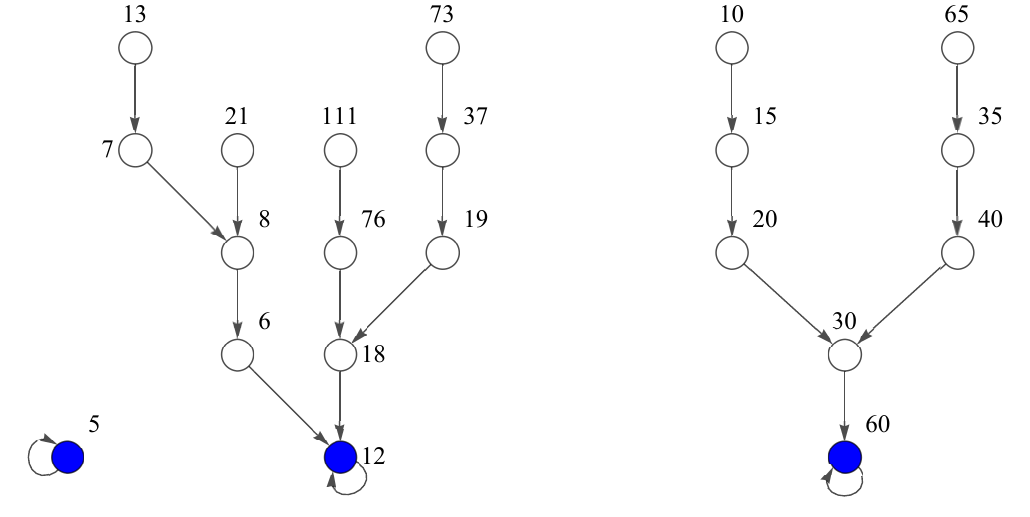
Figure 2. The finite orbits of 5 (loop), 13, 10, 21, 65, 73 and 111 (fixed points are colored in